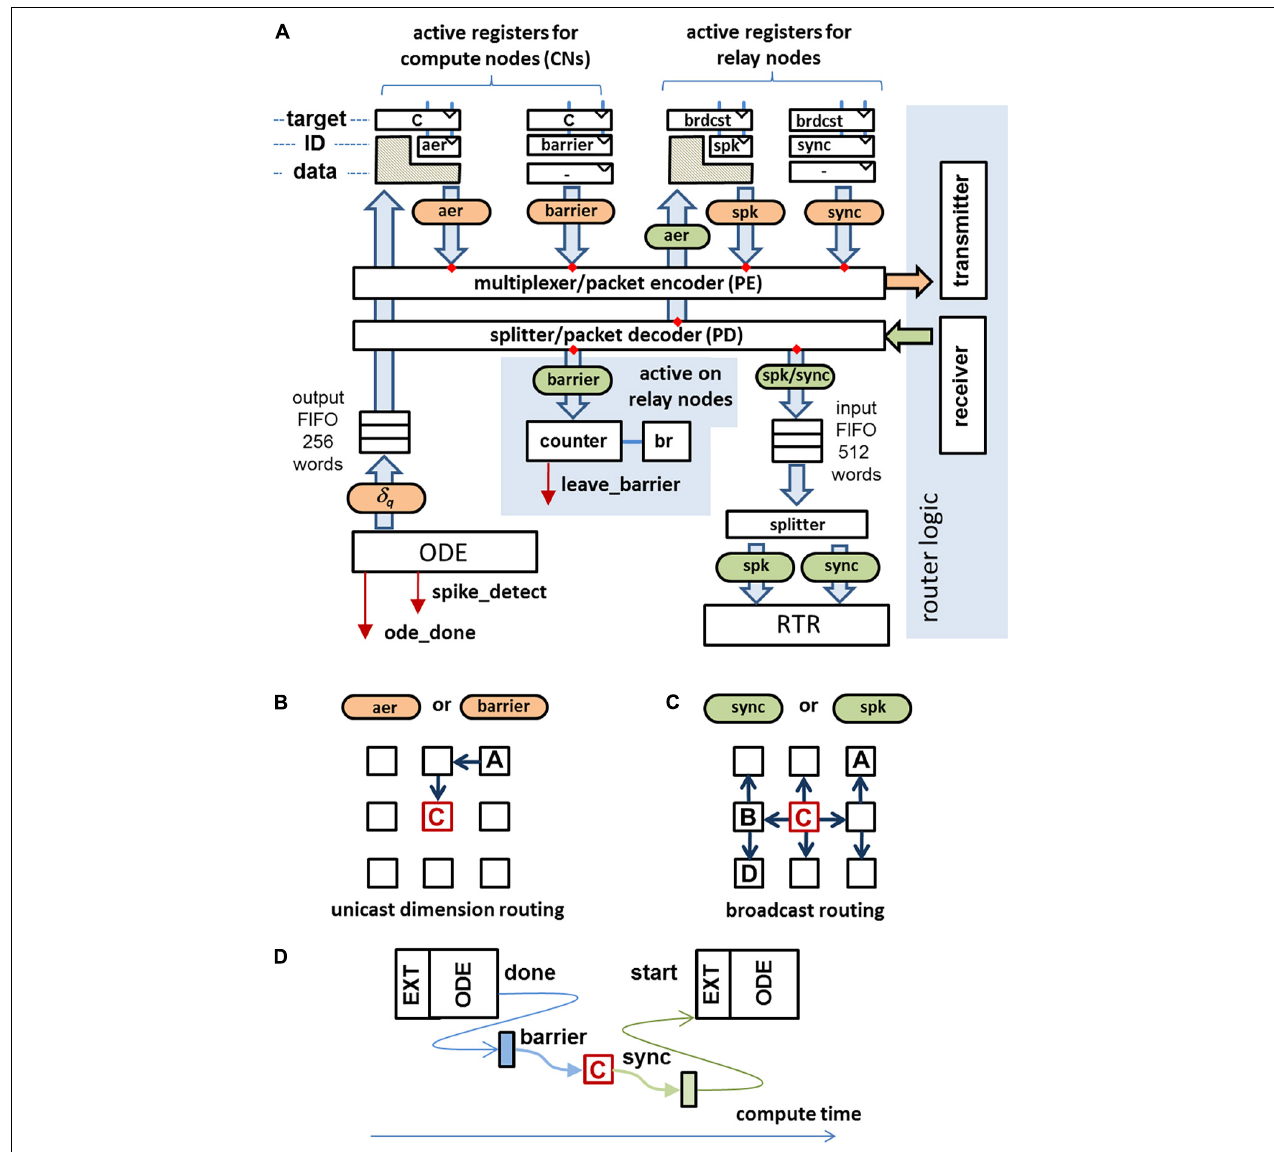
FIGURE 5 | (A) Data paths for communication in compute/master nodes. Received packets are marked in green, packets to send are colored in orange. The data fields of crosshatched regions will be replaced by the data field of the incoming packet. (B) Unicast routing used for the transmission of barrier messages and AER messages. (C) Broadcast routing used for the transmission of sync packets and spike packets. (D) After finishing the ODE processing a barrier message is sent to the master node. As soon as the barrier messages from all active CNs are received, the master node generates a sync message, allowing the CNs to proceed to the next algorithmic time